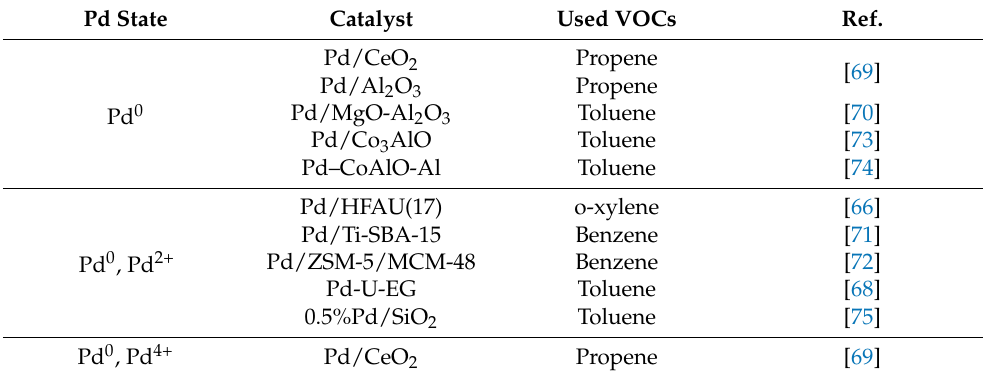
Table 3. Catalytic oxidation of VOCs over Pd catalysts with different Pd